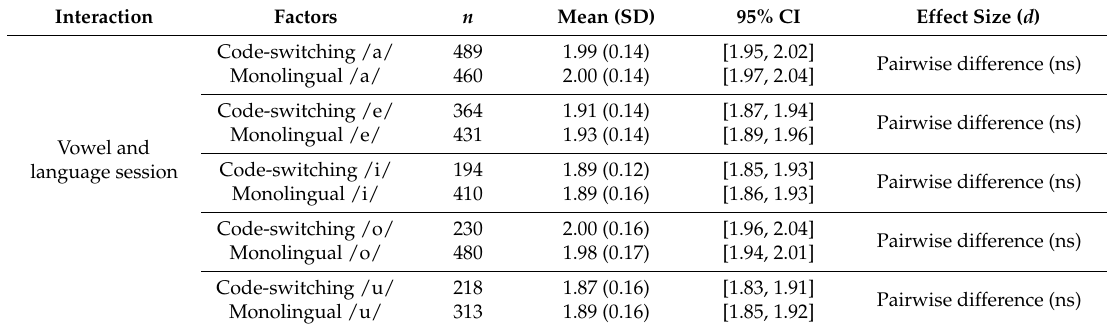
Table 6. Descriptive results for vowel duration (ms).